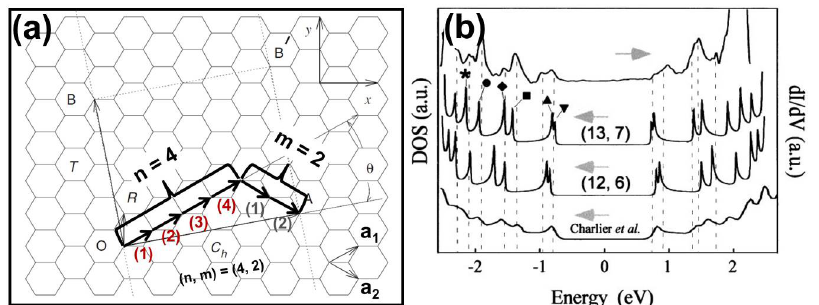
Figure 1. ( a ) Illustration of the graphene lattice, which serves as a template for carbon nanotube construction. The vectors a 1 and a 2 are the basis vectors of graphene in direct space. As illustrated, by displacing the lattice vector n times in the a 1 direction and m times in the a 2 direction, the chiral vector C h is formed, which together with the orthogonal vector T forms the unit cell of the carbon nanotube. The indices of the chiral vector ( n , m ) define the indices of the carbon nanotube. Namely, the rectangle AOBB’ is the unit cell in real space for the (4,2) tube, in which one chiral vector component is displaced four times in the a 1 direction and two times in the a 2 direction. The stripe formed (see dotted lines), which has a length equal to the size of C h , forms the carbon nanotube when it is rolled up. Figure adapted with permission from [4], Copyright Elsevier, 2006. ( b ) Van Hove singularities (VHS) obtained from scanning tunneling microscopy (STM) measurement, as shown in the upper curve, and theoretical calculations of the VHS for the ( 13,7 ) and the ( 12,6 ) carbon nanotubes. The vertical dashed lines indicate the VHS in the experimental curve. Reproduced with permission from [11], Copyright American Physical Society,